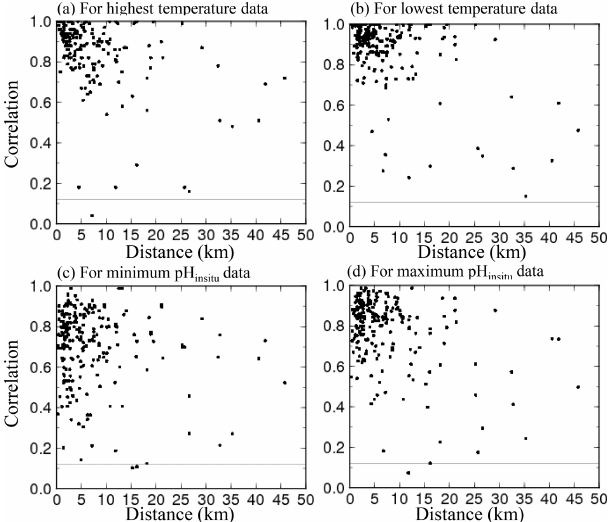
Figure 4. Correlations of water temperature and pH insitu at adjacent monitoring sites in the same prefecture. Thin lines denote signifi- cant correlations ( r = 0 . 12, degrees of freedom =